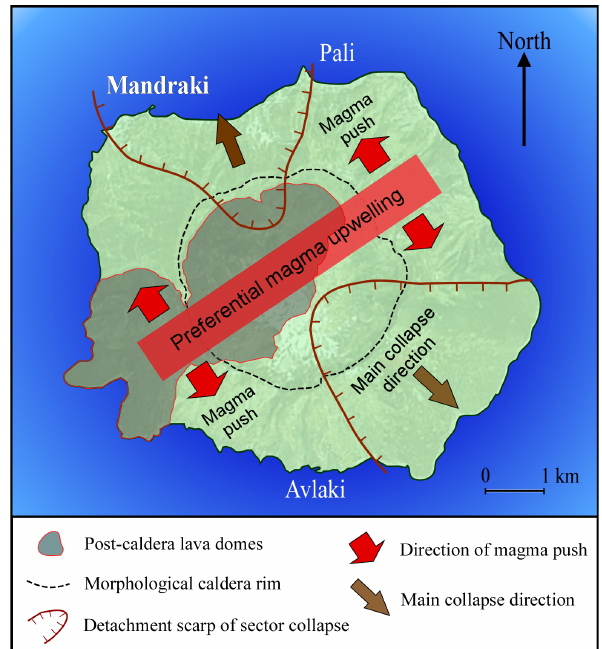
Fig. 4. Sketch illustrating the geometrical relationships between the preferential NE-SW zone of magma injection across Nisyros island and the location and failure direction of two sector collapses (mod- ified after Tibaldi et al., 2008). The post-caldera domes are also marked to illustrate their correspondence with a NE-SW trending magma injection. The collapse towards the NW is documented by Vanderkluysen et al. (2005) and the collapse towards the SE is doc- umented by Tibaldi et al. (2008). Repeated magma injections are suggested by Tibaldi et al. (2008) to generate a lateral magma push directed perpendicular to the NE-SW zone, which in turn causes destabilization of the volcanic edifice and thus may explain the ori- entation of these two sector